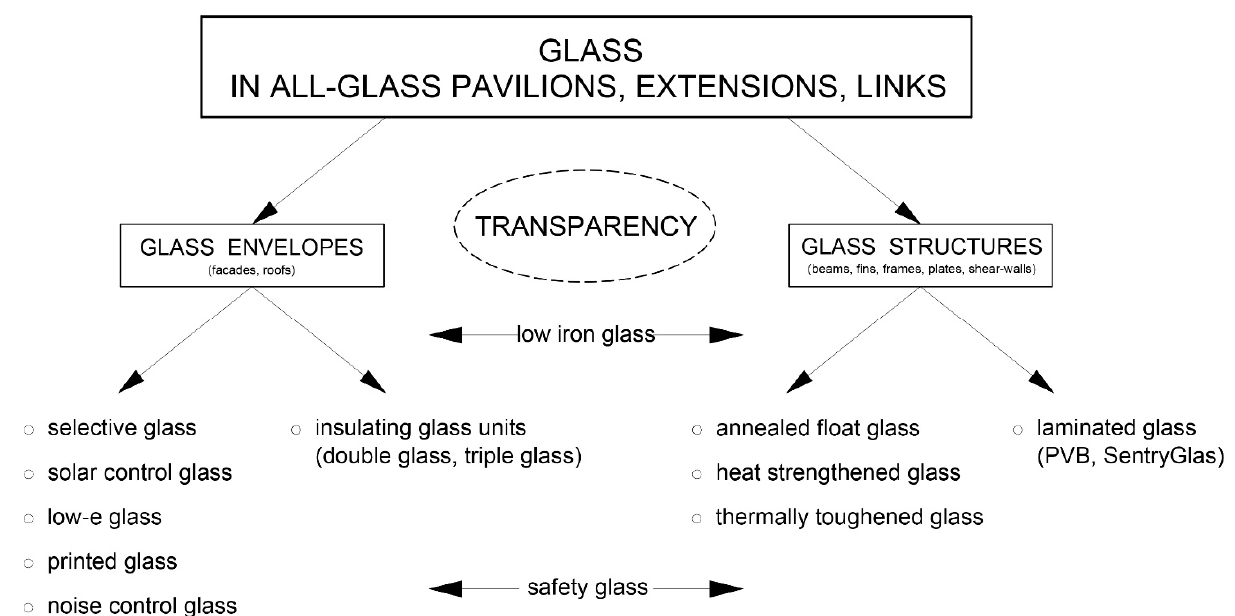
Figure 2. General characteristics of glass used in all-glass pavilions, extensions, and links (figure by the author). the